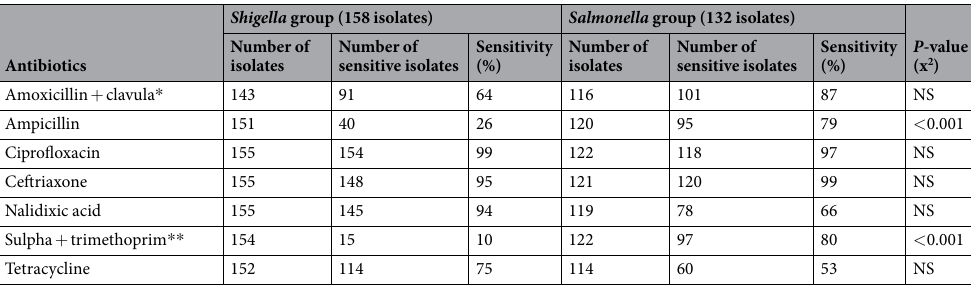
Table 3. Sensitivity patterns of Shigella and Salmonella groups to various antibiotics. * Amoxicillin + clavulanic acid. ** Sulphamethoxazole and trimethoprim. NS, not